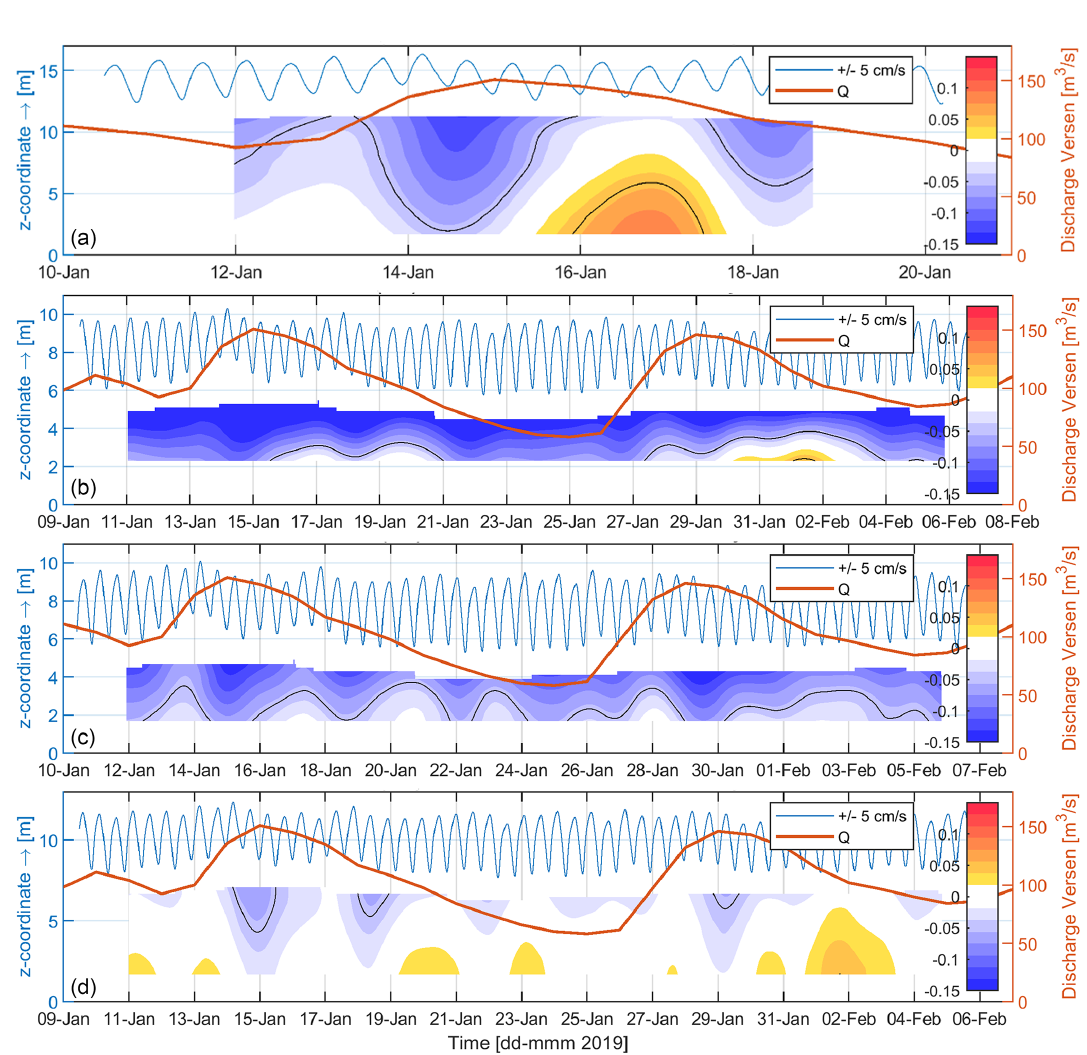
Figure 7. Godin-filtered residual longitudinal flows (landwards positive) measured with the bottom mounts (BMs) at stations GAT (a) , GEI (b) , EFW (c) and DOL (d) in 2019. A Godin low-pass filter removes tidal flow velocities from the observation, showing temporal variations of the average flow